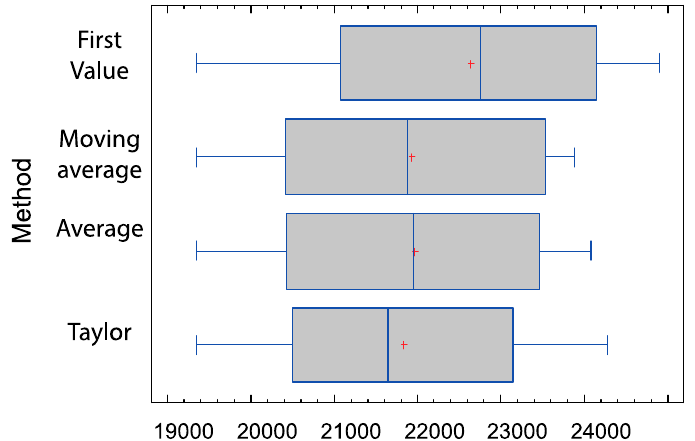
Figure 5. Distribution of the initial values obtained for the level in the additive trend models AMC 24,168 y AAC 24,168 .